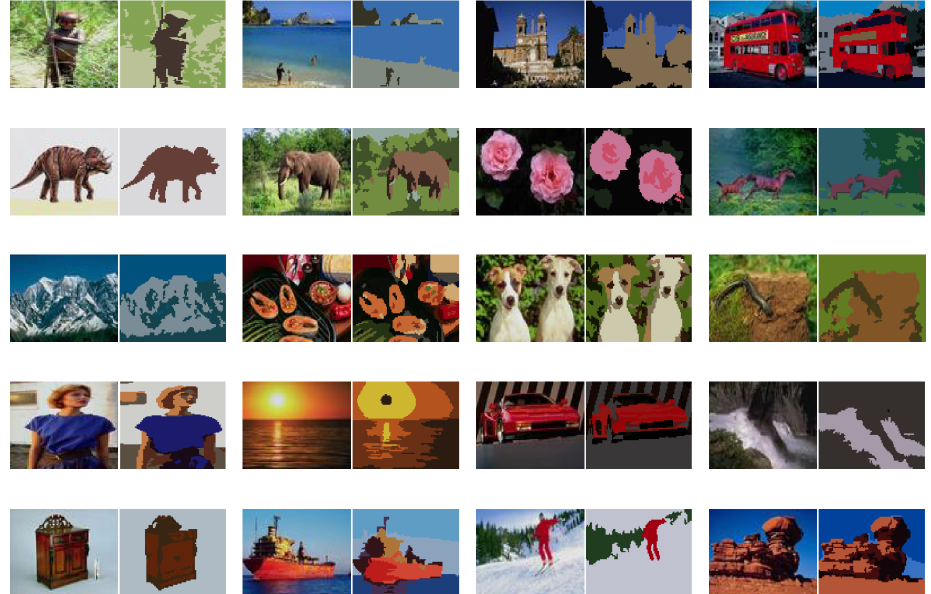
Figure 12. Images randomly sampled from 20 categories of the COREL dataset and the corresponding segmentation results. Segmented regions are shown in their representative